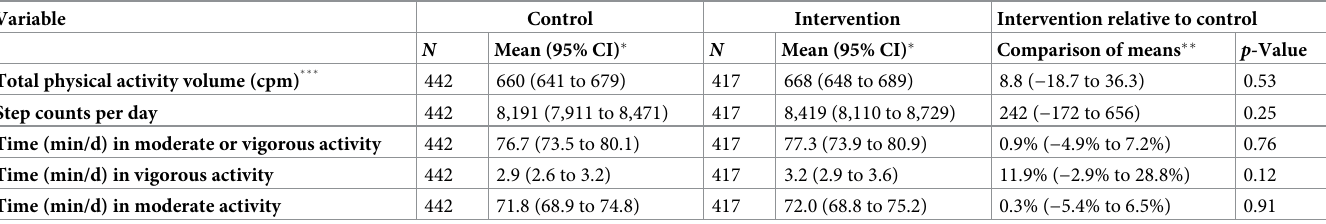
� Means are geometric means for time in activity at different intensities and compared as the percentage by which the intervention group’s geometric mean is raised relative to that in the control group after adjustment for covariates. �� Comparison of means is adjusted for sex, 5-year age group, and practice. ��� These are vector magnitude cpm.